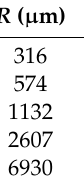
Table 3. Effectiveness factor (EF) and Thiele modulus as a function of the particle radius ( R ) for the different β -galactosidase catalysts used in the calculation of the conversion curves for the hydrolysis of lactose at 35 °C.